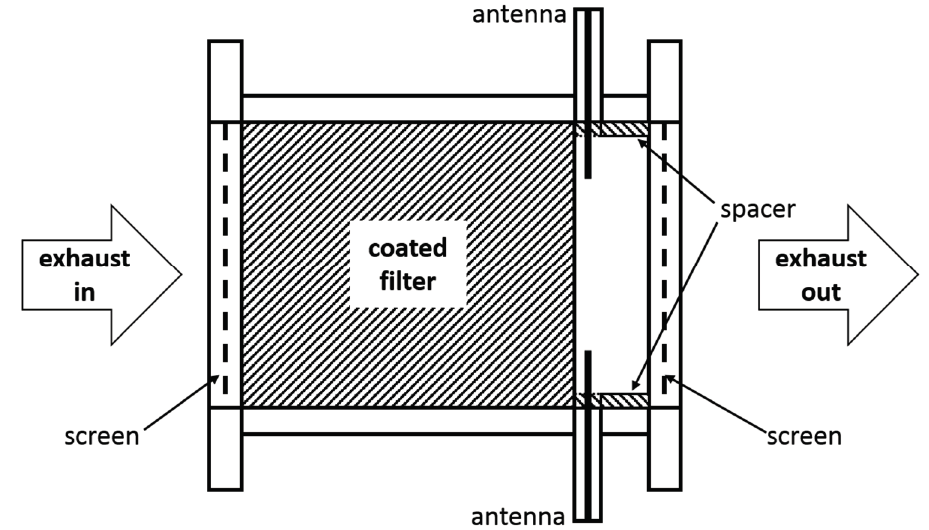
Figure 1. Illustration of the filter canning, used for the engine experiments: for the microwave measurements, two probe antennas downstream of the GPF and two metal screens (one up- and one downstream of the GPF) were added to the conventional